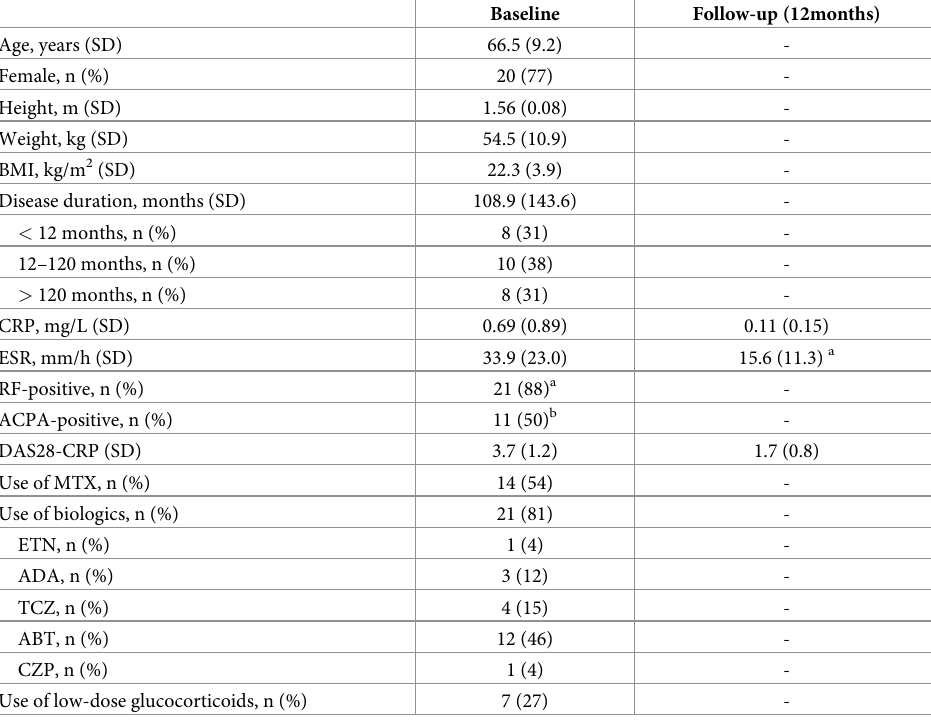
Table 2. Characteristics of RA patients (n = 26).